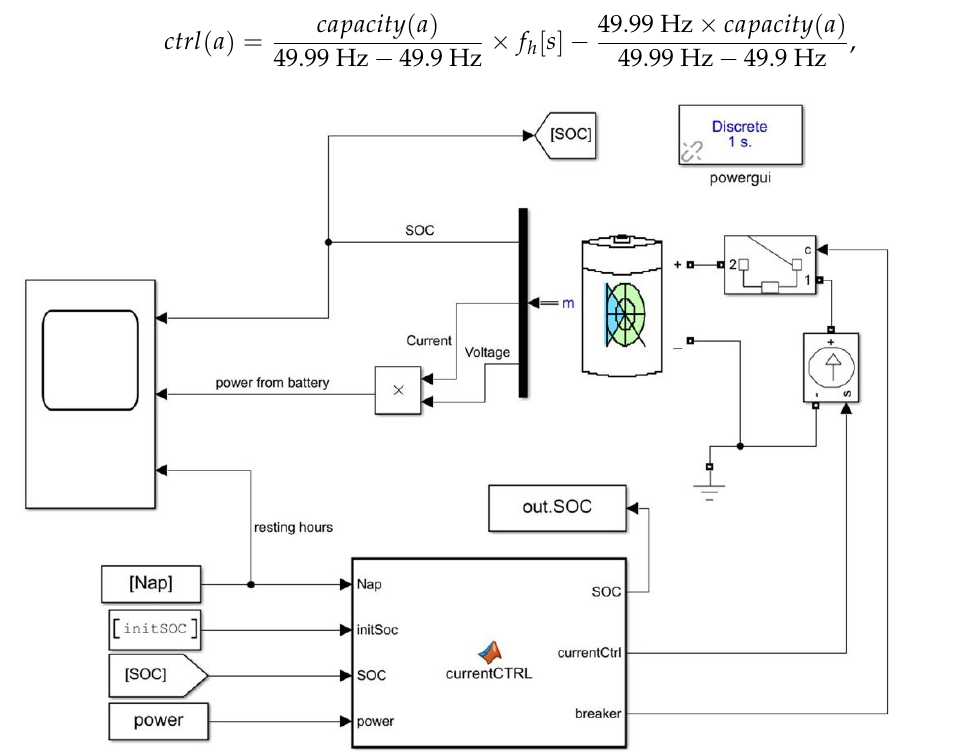
Figure 4. Battery simulation model.